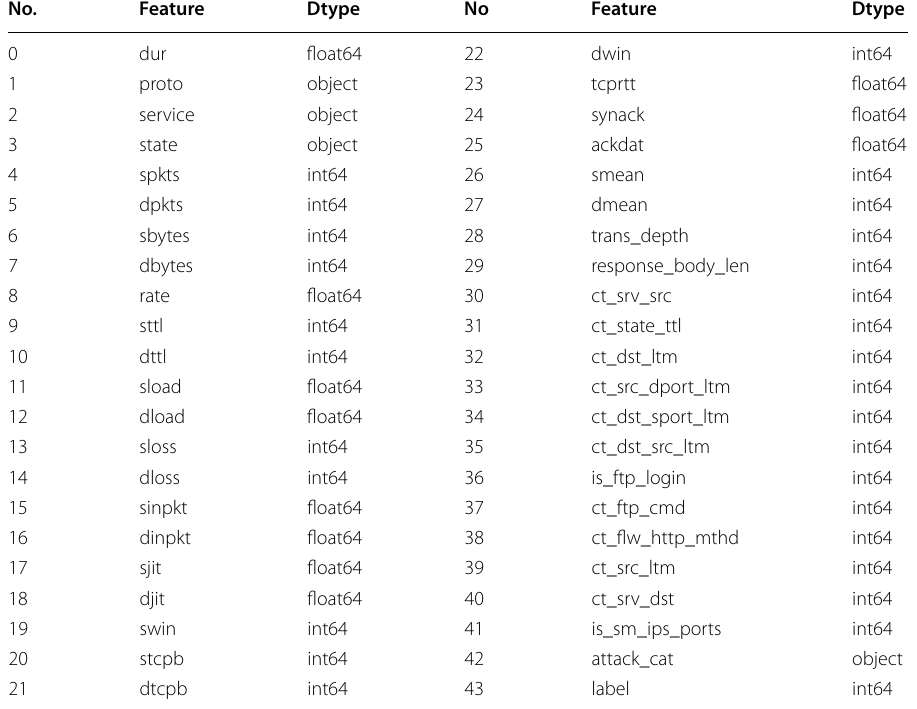
Table 3 UNSW‑NB15 feature data types